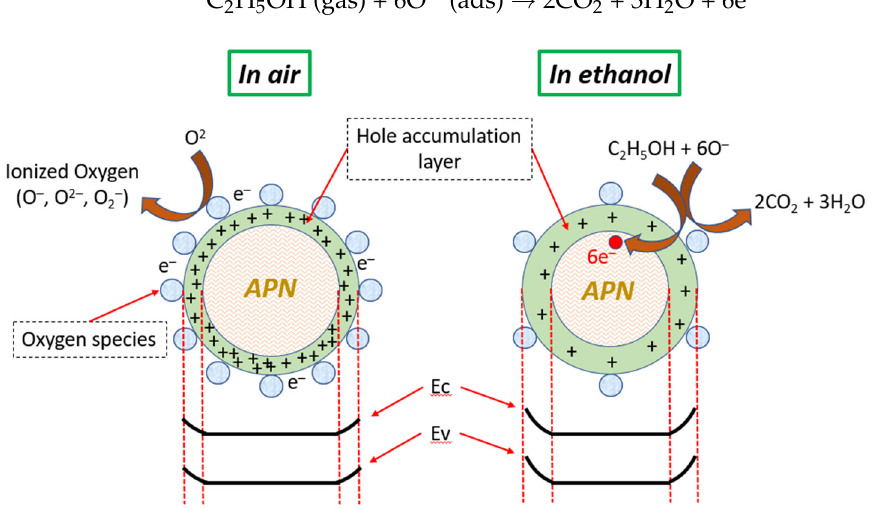
Figure 10. Schematic diagram of the gas-sensing mechanism of an APN device in the air and in ethanol.